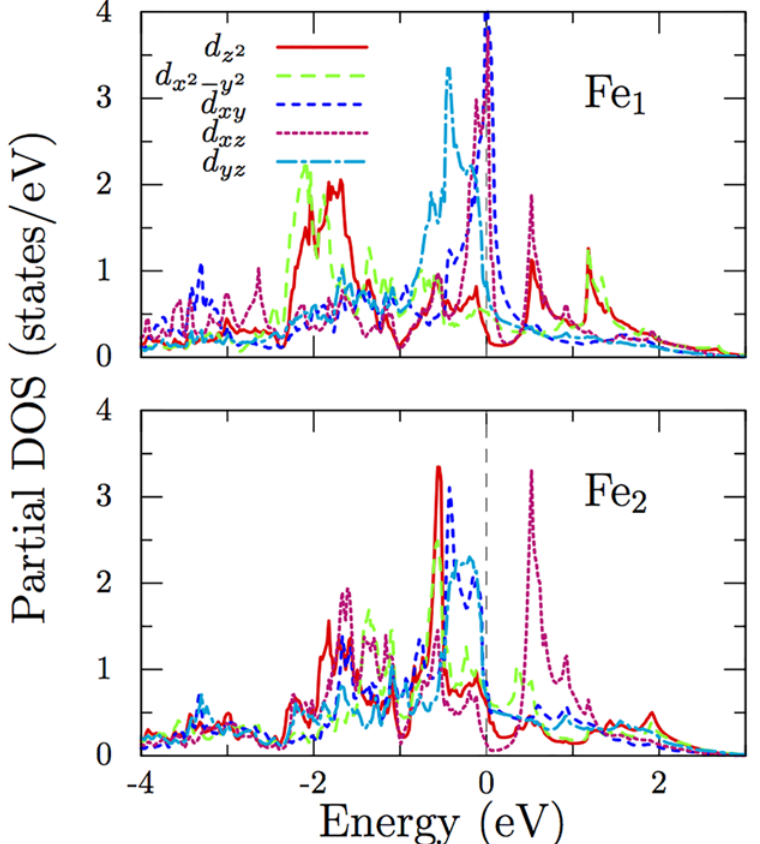
Fig 5. Partial density of states for Fe- d states. Contributions from the d states of Fe 1 and Fe 2 ions near the Fermi level from the non-magnetic calculation show that all states contribute significantly to the density of states. The crystallographic axes are taken as the coordinate system for